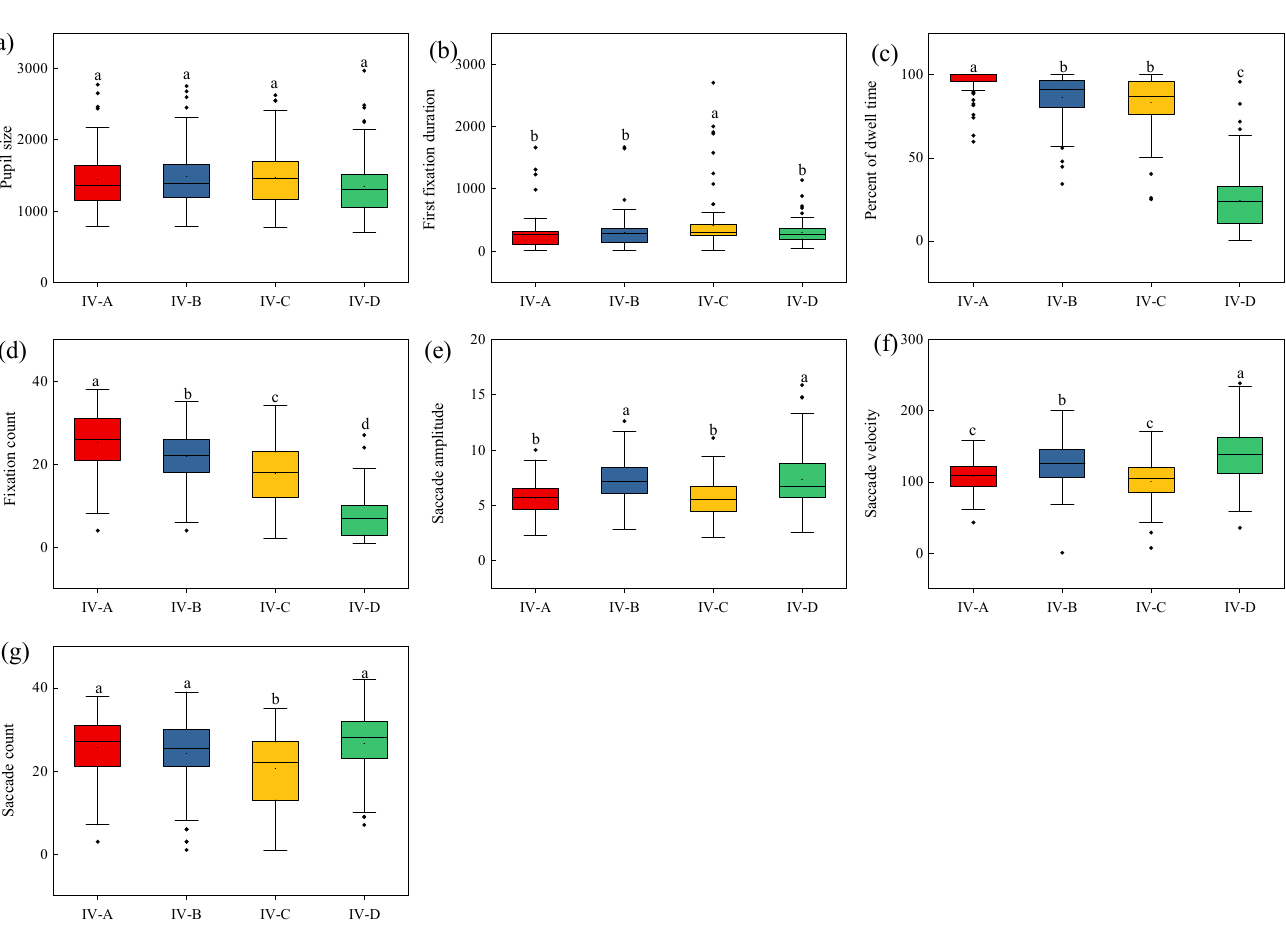
Figure 6. Eye-tracking measures for different layers are shown, ( a – g ) represent pupil size, first fixation duration, the percentage of dwell time, fixation count, saccade amplitude, saccade velocity, and saccade count, respectively; IV-A–IV-D represent tree + shrub + grass, shrub + grass, shrub, and grass, respectively. Different lowercase letters indicate significant differences among different attributes with the same category ( p < 0.05). Little square represents the mean and rhombus filled with black represents outliers.